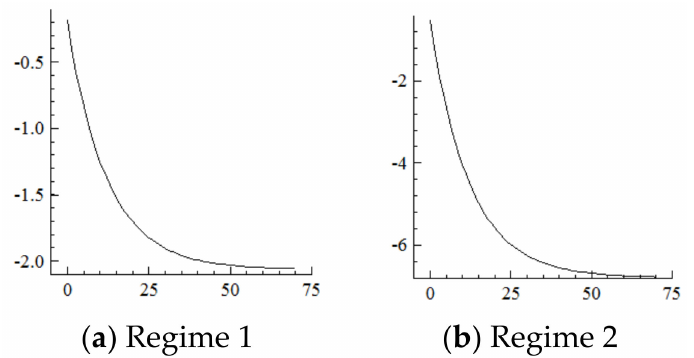
Figure 9. Cumulative Impulse Response of Consumption to Population Aging Shocks.